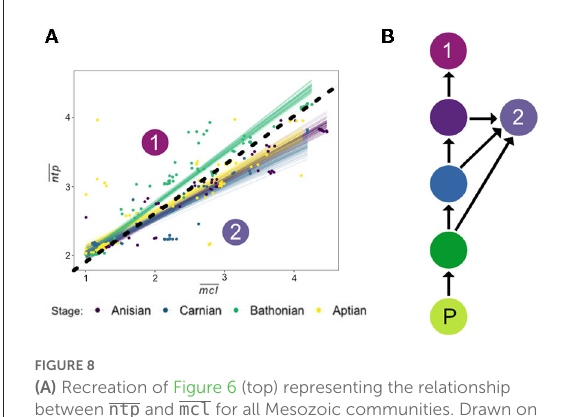
FIGURE8 (A) Recreation of Figure 6 (top) representing the relationship between ntp and mcl for all Mesozoic communities. Drawn on the plot is a line delineating two groups referenced in the Discussion, which include the Bathonian in Group 1, and the Anisian, Carnian, and Aptian in Group 2. (B) Schematic diagram of proposed difference in food chain ntp vs. mcl in Group 1 and Group 2. Where in Group 1 the top consumer feeds only high in the food chain, the top consumer of Group 2 displays trophic omnivory by feeding on intermediate consumers lower in the trophic chain. P, primary